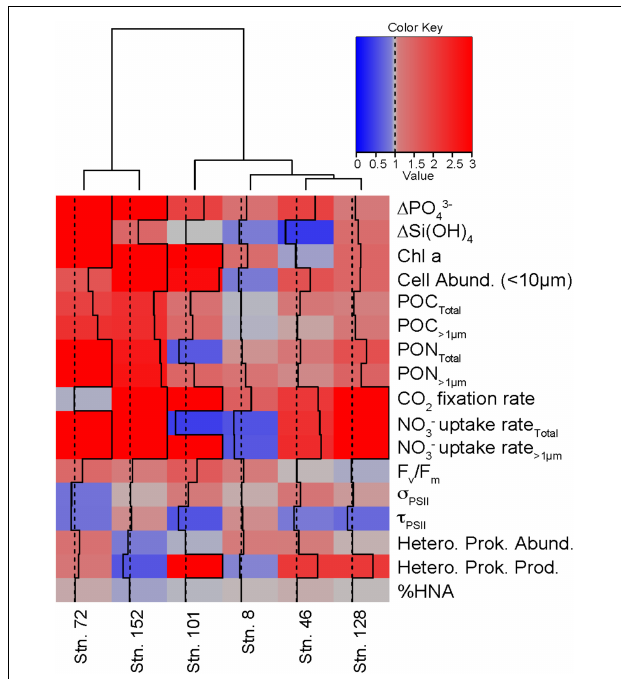
FIGURE 9 | Comparison of different experiments showing the relative response (+NO 3 − : Control) for multiple variables in each experiment. Dotted line indicates value of 1 while solid line indicates the value of the responses. Values ≥ 3 are indicated by solid line on the right edge of the box. Hierarchical clustering using Ward’s minimum variance method was used to group experiments with similar relative